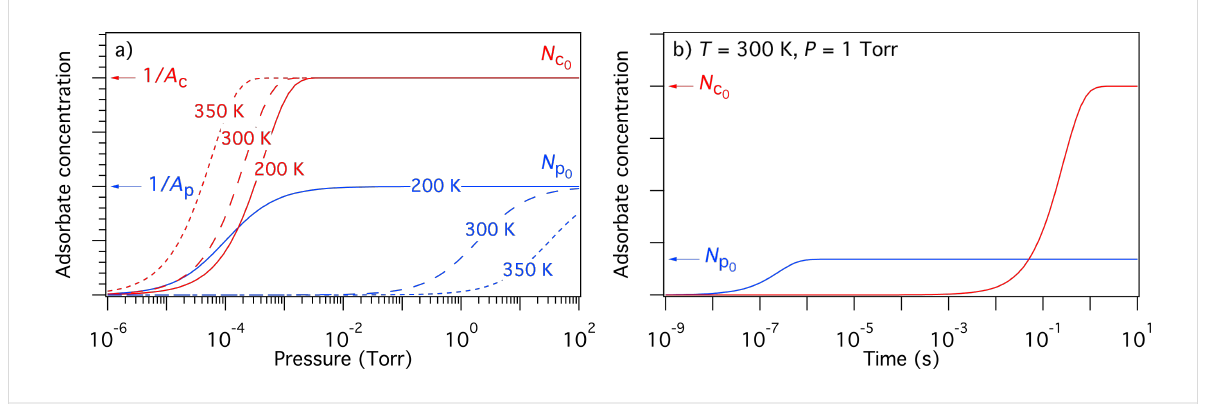
Figure 13: (a) Steady state concentrations of physisorbed and chemisorbed adsorbates versus pressure, calculated for the case of zero electron flux, and substrate temperatures of 200, 300 and 350 K. (b) Time-dependence of N p and N c calculated for a substrate temperature of 300 K and a precursor gas pressure of 1 Torr. (In all cases, gas temperature = 300 K; E p = 510 meV, E conv = 1.415 eV, E c = 855 meV; f = 0; A p = 2 A c and n c = 2 to represent a dissociative chemisorption process in which the precursor molecule fragments into two chemisorbed molecules. All other model input parameters were the same as in [5].)